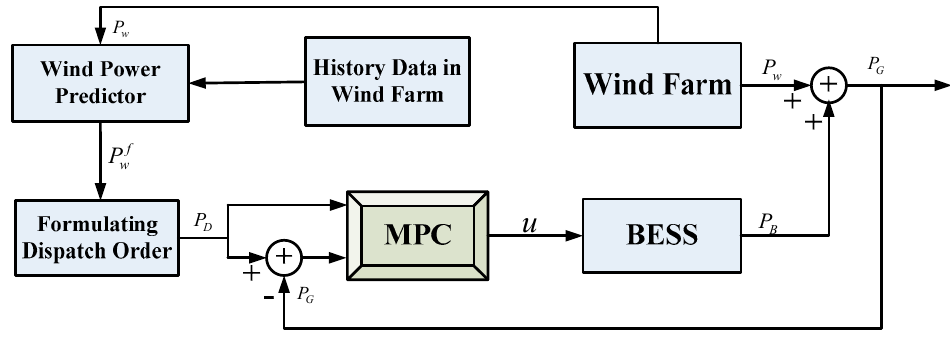
Figure 3. Diagram of smoothing and dispatching wind power via MPC.